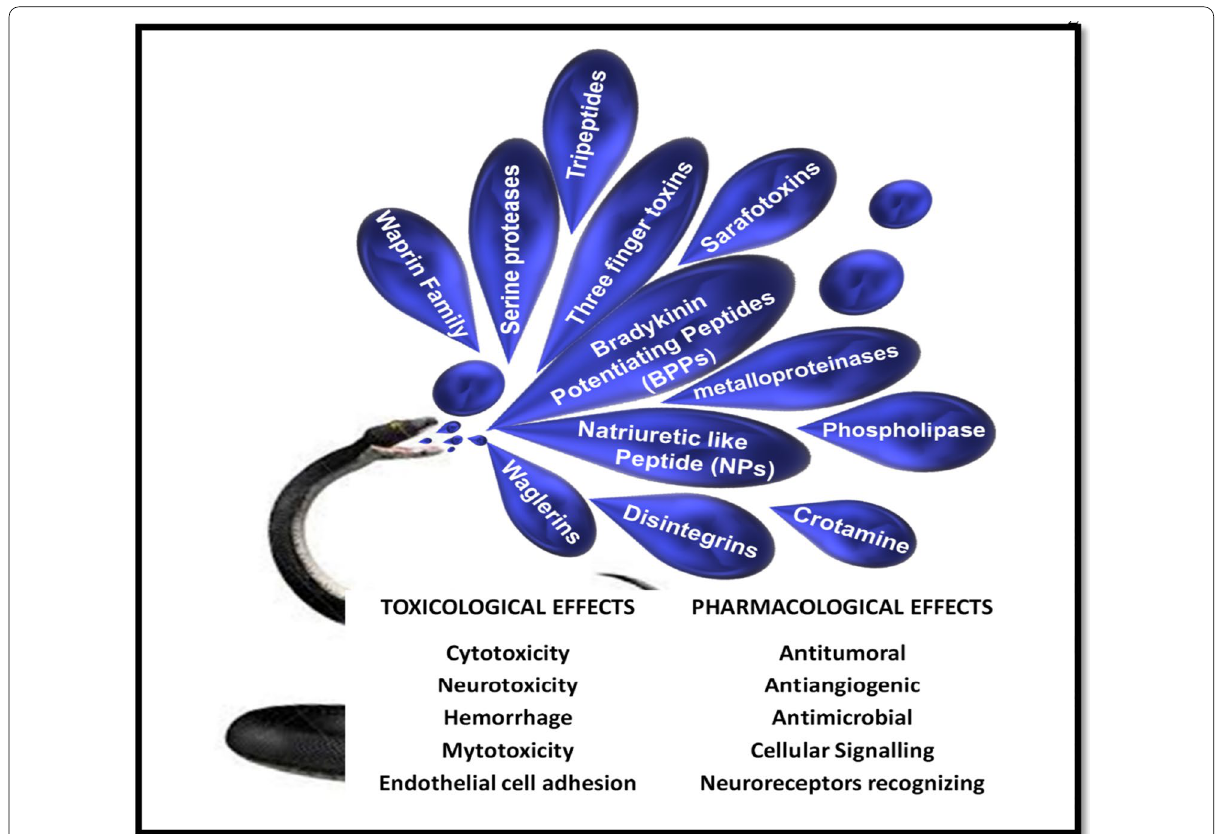
Fig. 3 Different types of venom peptides present in venom, their pharmacological and toxicological